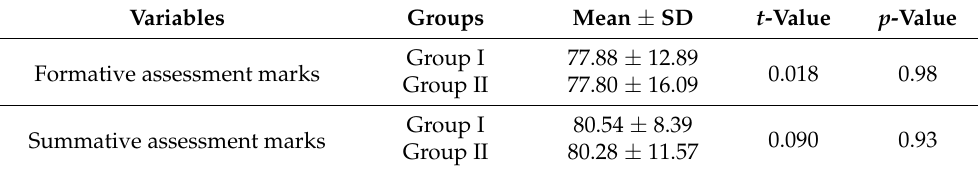
Table 2. Comparison of formative and summative assessment marks between the two groups.